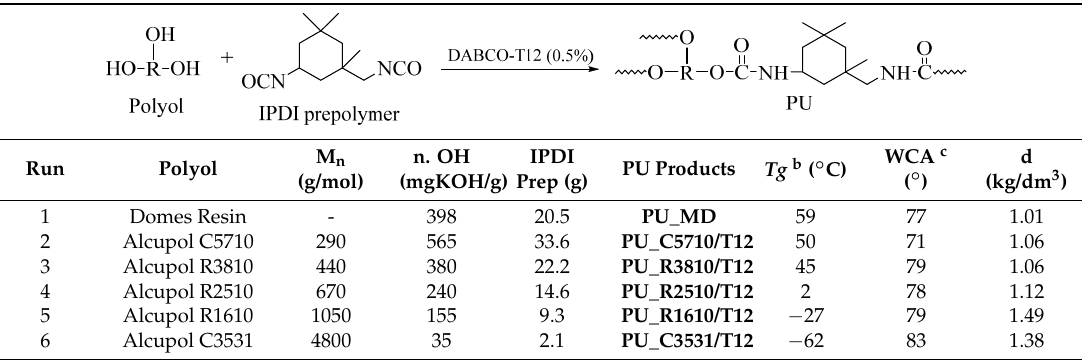
Table 1. Screening of commercial polyols a .